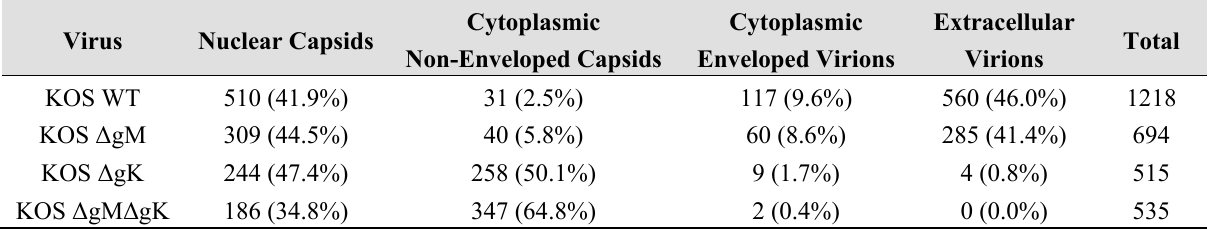
Table 4. Virus particle quantification from TEM